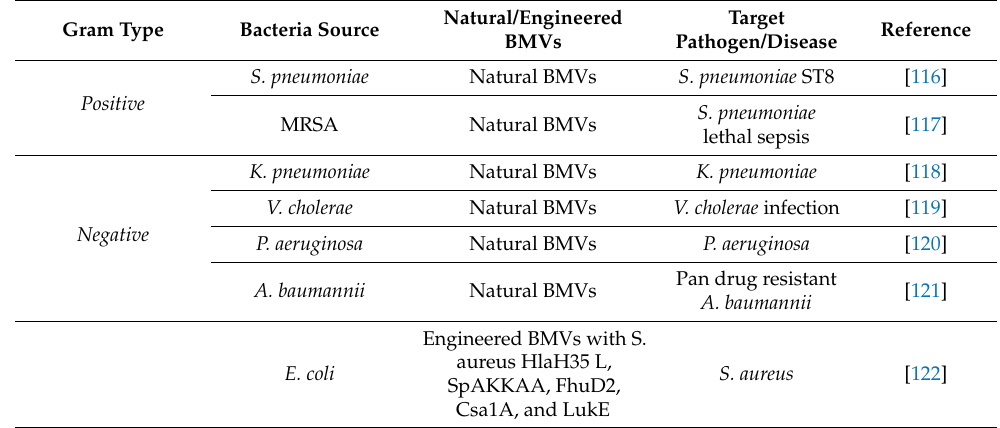
Table 2. Natural and engineered bacterial membrane vesicles that have be used as vaccines against some of the deadliest homologous or heterologous antibiotic-resistant bacterial